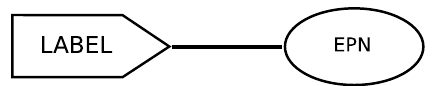
Figure 2.53: The Process Description glyph for Equivalence arc